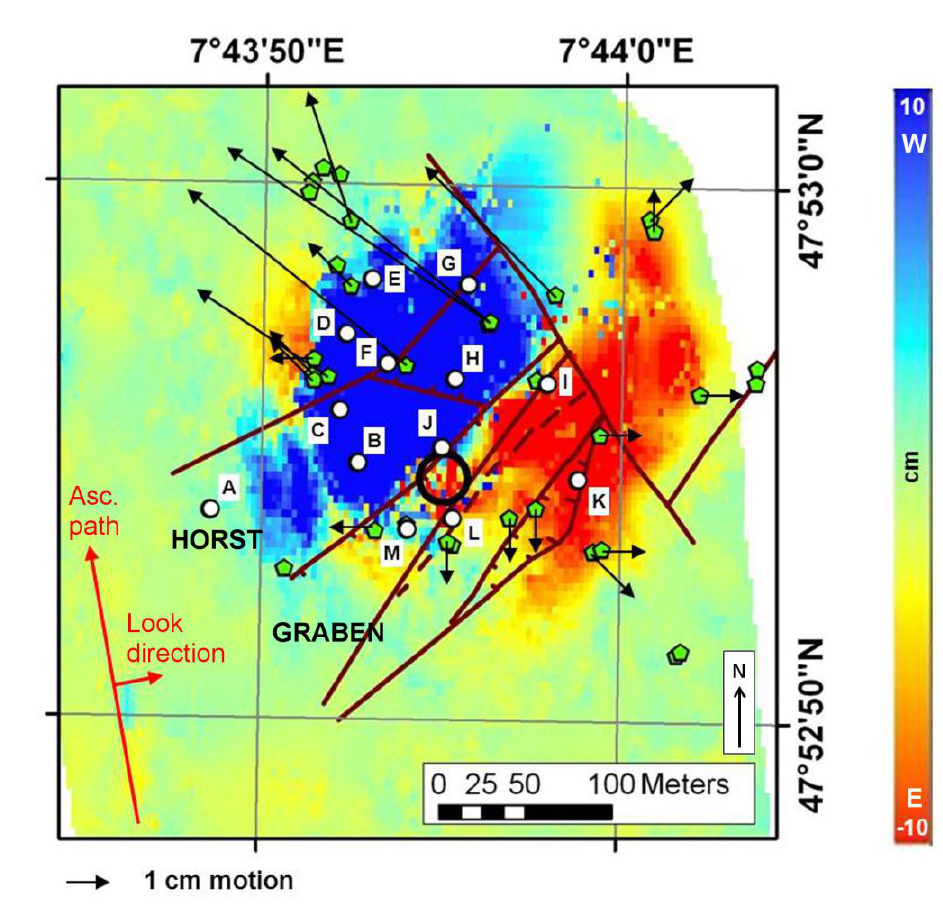
Figure 7. Indication of horizontal motions in approximately east- (red) and westward (blue) direction that is revealed by subtracting interpolated cumulative Small BAselines Subset (SBAS) line of sight (LOS) displacement and interpolated leveling results of the 2008–2011 period from [3]. Ascending orbit path and eastward look-direction (range) are displayed. Green filled pentagons show locations of survey points, for which annual dislocation measurements are performed. Arrows display horizontal motions for the period from 26 September 2011 through 7 October 2013. Local faults at 50 m depth (brown line features) as detected by the State Office for Geology, Resources and Mining (LGRB) were added. The locations, whose time series are presented in Figure 6, are marked with white filled